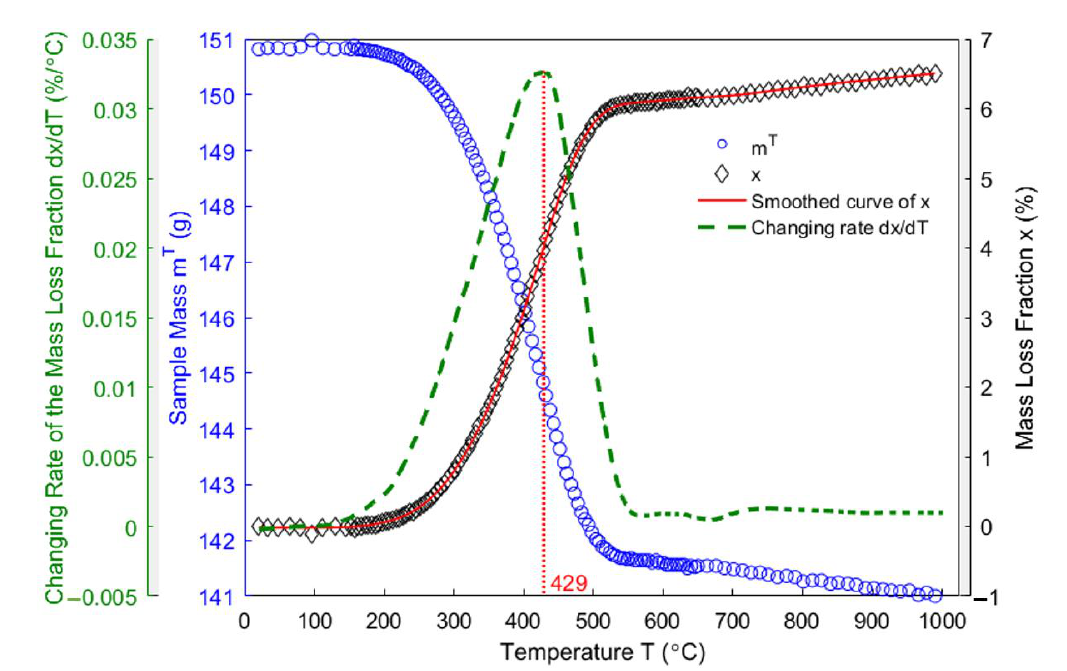
Figure 5. Evolution of the mass, the mass loss fraction and the changing rate of the mass loss fraction of the anode sample. From 527 °C to 627 °C, only 0.11% of mass is lost, which indicates that the pitch car- bonization has nearly terminated, and a semi-coke has been formed [39]. Upon further